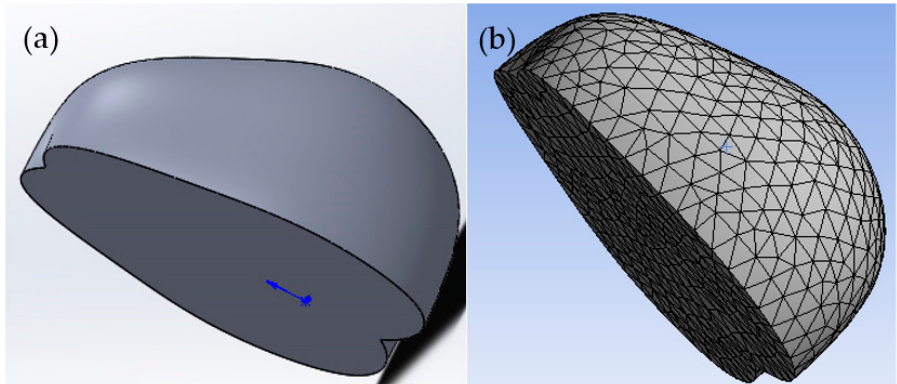
Figure 2. The 3D model ( a ) and FE mesh ( b ) of an apple sample.